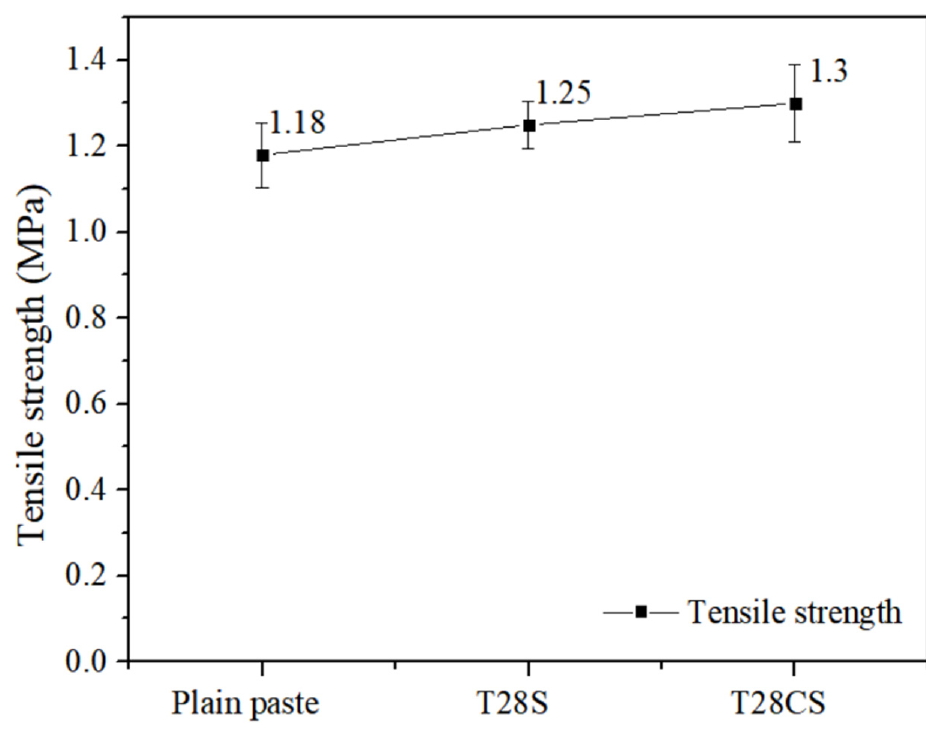
Figure 3. Results from tensile strength test.